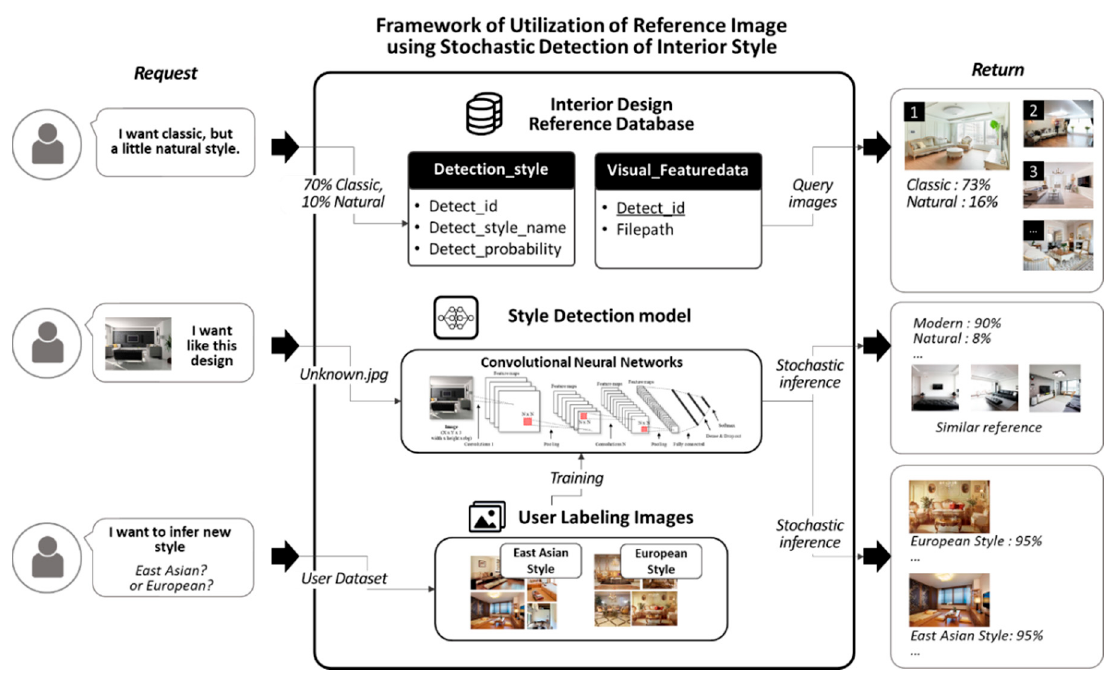
Figure 7. Concept for stochastic detection of interior design styles and its application to reference images.